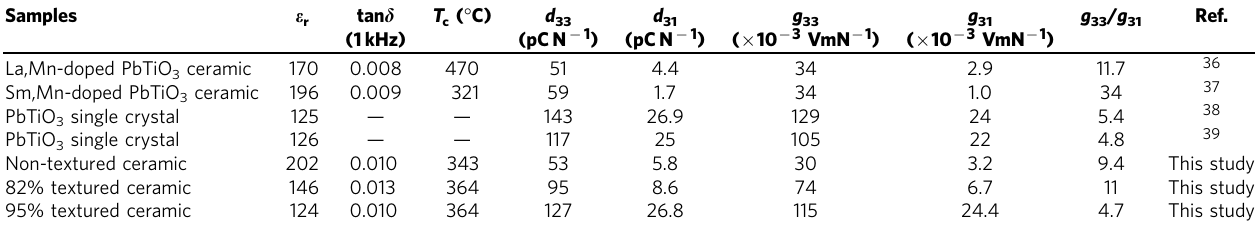
Table 1 | Dielectric, ferroelectric and piezoelectric properties of nontextured, textured PT ceramics and PT single crystal.